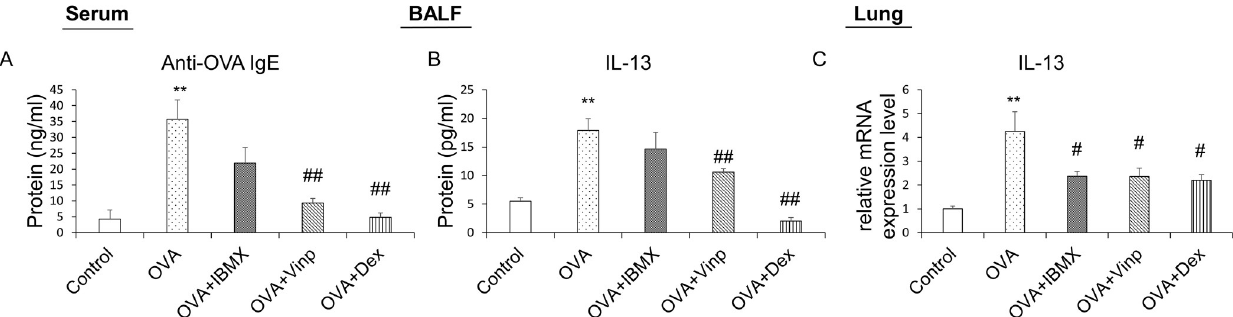
Fig 3. Effects of IBMX and Vinp on OVA-induced increase in allergic inflammatory mediators. Plasma samples obtained from mice were analyzed by ELISA to investigate systemic allergic inflammation. ( A ) Anti-OVA IgE in serum and ( B ) the release of IL-13 in BALF were measured by ELISA. The mRNA expression levels of ( C ) IL-13 in lung tissues were measured by RT-qPCR. Data are expressed as mean ± SEM. Statistical analysis was performed using one-way ANOVA (Data were considered significant at �� P < 0.01 compared with the control group and # P < 0.05 and ## P < 0.01 compared with the OVA group). IBMX, 3-isobutyl-1-methylxanthine; BALF, broncho-alveolar lavage fluid; OVA, ovalbumin; Vinp, vinpocetine; Dex, dexamethasone.